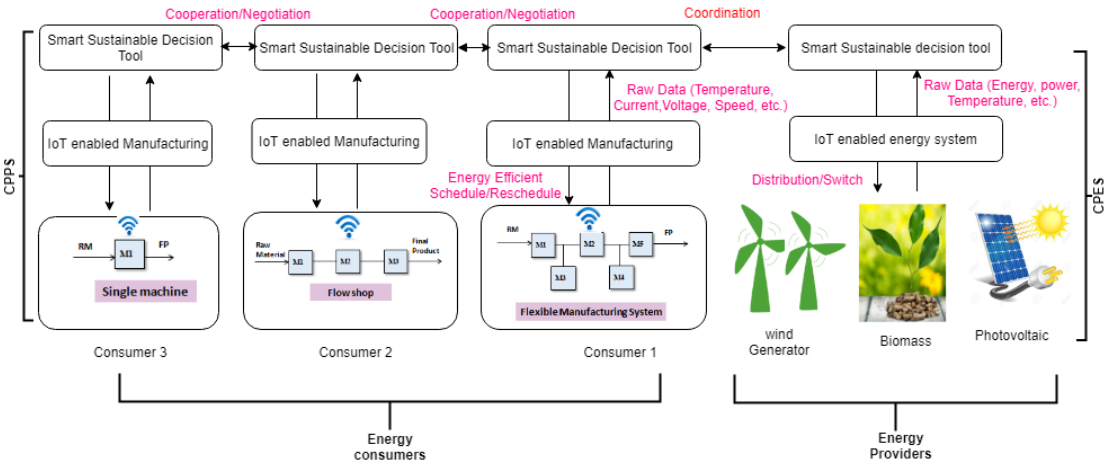
Figure 2. A general view of the EasySched